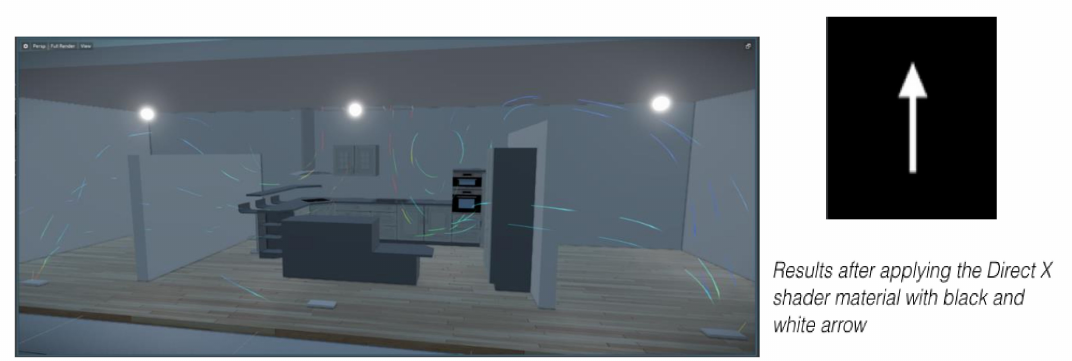
Figure 13. Airflow animation with gradient color ( left ); the gradient color image ( right ).